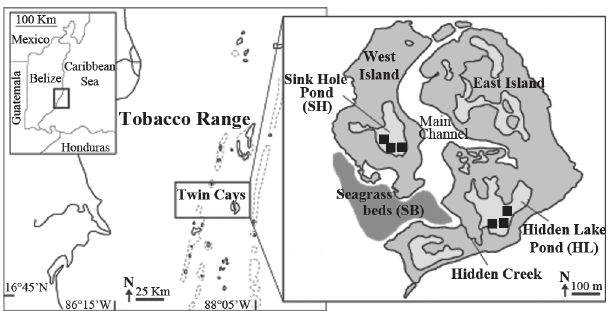
Fig. 1. Location of the two mangrove ponds (black squares), Sink Hole (SH) and Hidden Lake (HL), and the seagrass beds (grey area) sampled in the offshore islet of Twin Cays in Belize. Hidden Lake pond connects with the Main channel by the Hidden Creek.